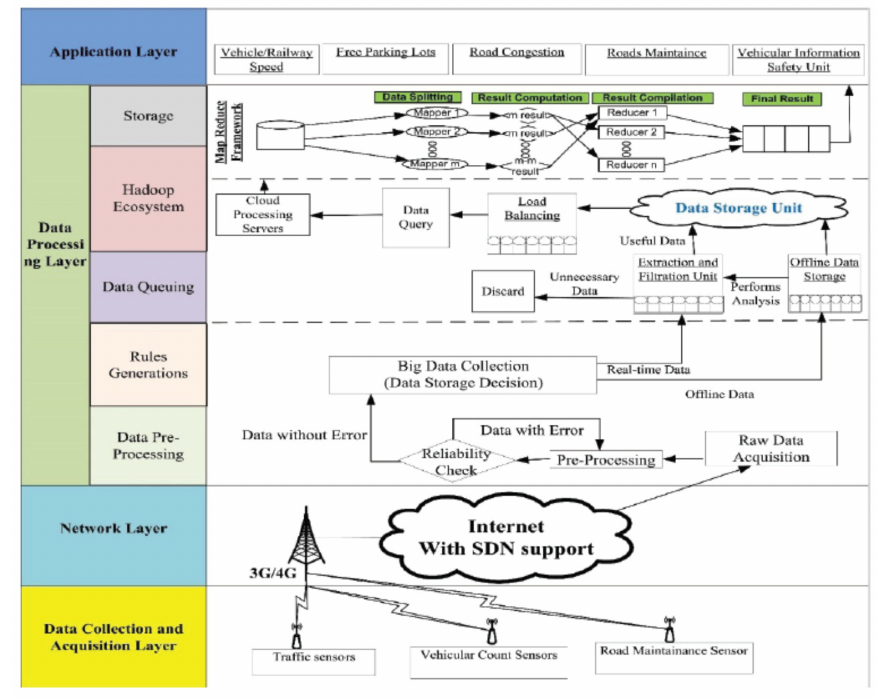
Figure 19. Four layered architectures for Big data analytics